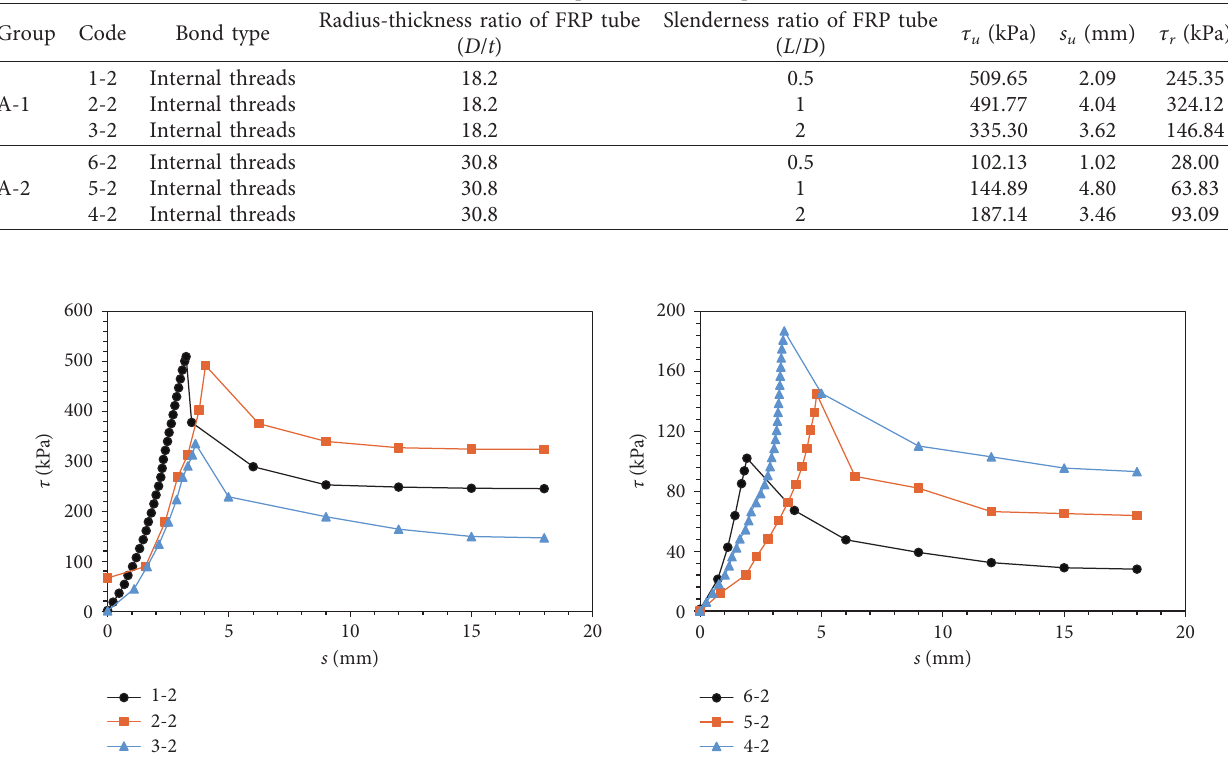
Figure 6: Failure modes of specimens. (a) Shear failure of FRP tube-concrete interface. (b) Shear connectors were pulled out. Table 5: Test results of specimens in Group A-1 and A-2.